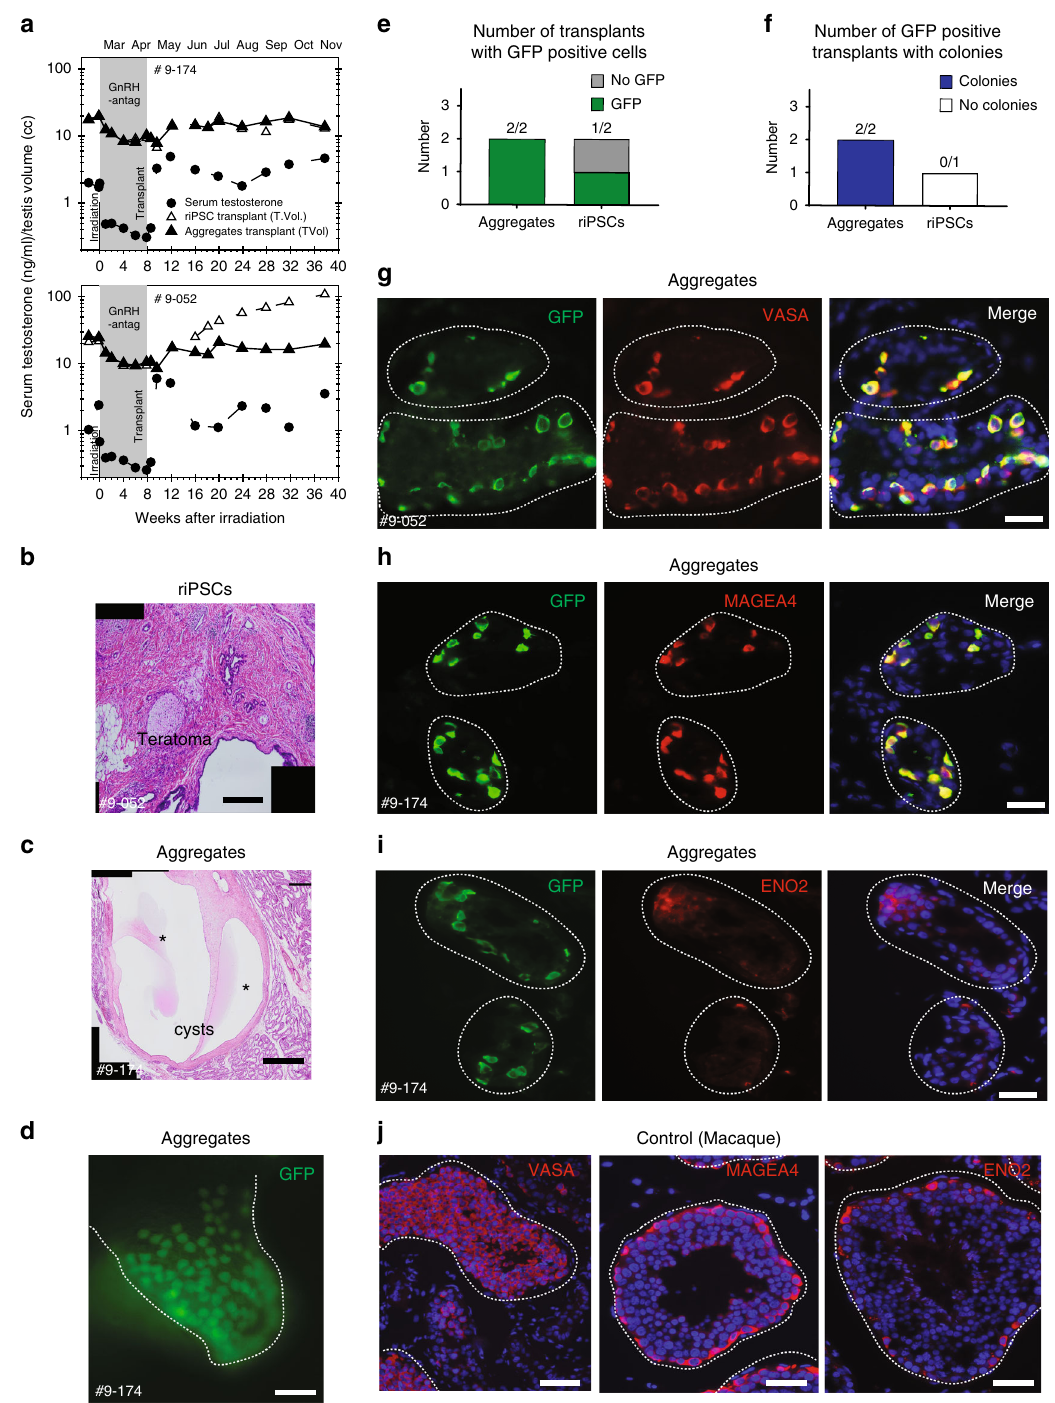
Fig. 6 Homologous transplant of rPGCLCs results in differentiation to late rPGC stage. a The volume of recipient testicles that received donor Day (D) D8 riPSC89 UbiC:GFP aggregate cells returned to baseline levels, comparable to the volume prior to irradiation and subsequent GnRH antagonist treatment. In contrast one recipient male who received riPSC89 UbiC:GFP cells exhibited a volume increased. b H&E staining of the abnormally large recipient testicle transplanted with riPSC89 UbiC:GFP revealed teratomas. Scale bars, 400 µ m. c H&E staining of aggregate recipient testicles reveals large cysts (asterisks) near normal tubules. Scale bars, 400 µ m. d Expression of GFP in recipient testicles transplanted with D8 riPSC89 UbiC:GFP aggregate cells within the seminiferous tubules (white dotted lines). Scale bars, 40 µ m. e A graph of the number of transplants that had GFP positive donor cells. f Graph of the number of GFP positive transplants with colonies. g – j IF on sections of rhesus recipient testicles that received a single cell suspension of aggregate donor cells (GFP positive, green). The surviving donor cells co-expressed the late stage rPGC markers g VASA (red) and h MAGEA4 (red), but not i ENO2. Nuclear staining using DAPI (blue) is shown in merged panels for g – i . Scale bars, 40 µ m. j Positive IF staining of rhesus adult testicle for VASA (red), MAGEA4 (red), or ENO2 (red) in combination with the nuclear marker DAPI (blue). Scale bars, 40 µ